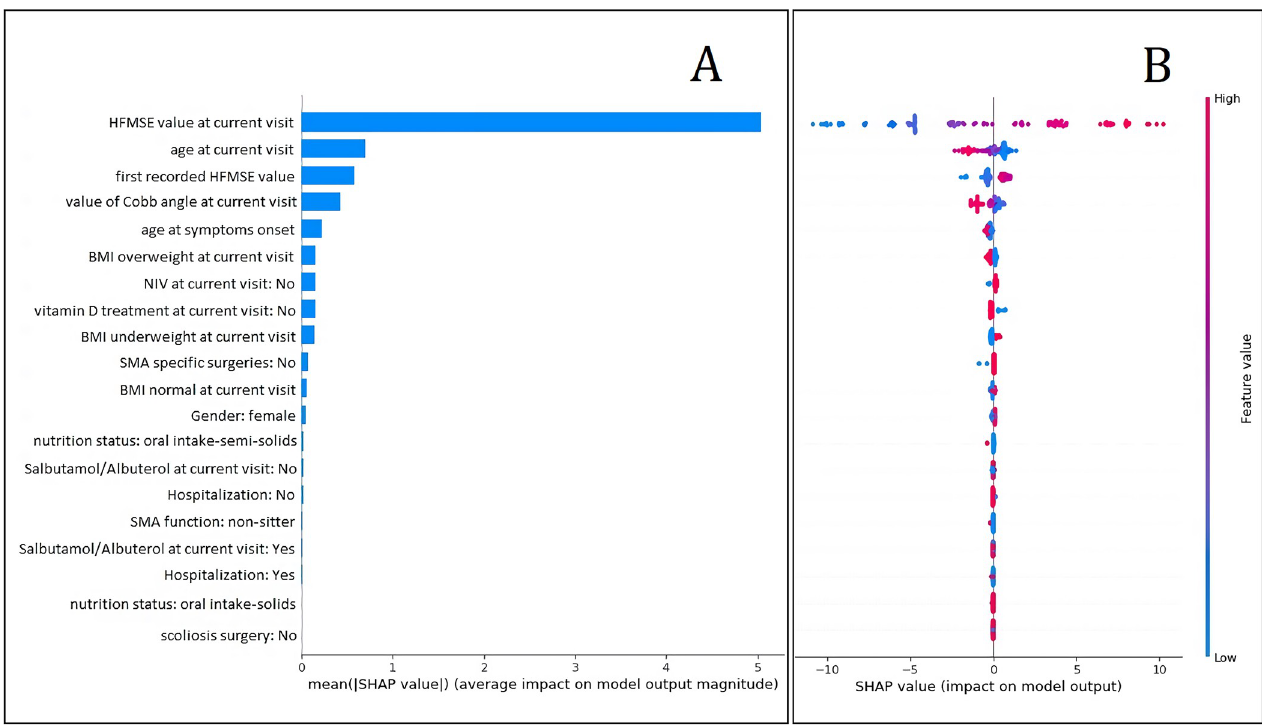
Fig 2. Top 20 features importance for 6 months model according to mean SHAP value (A) and SHAP value (B).